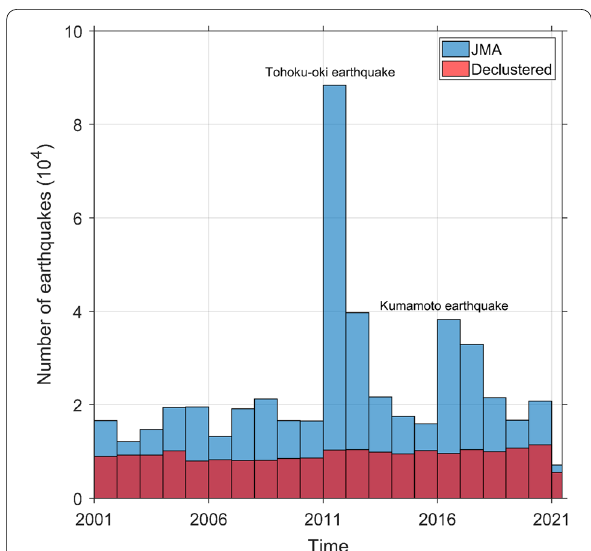
Fig. 2 The JMA earthquake catalogue (blue) and declustered earthquake catalogue (red). We use aftershock time–space identification windows from Gardner and Knopoff (1974). Earthquake swarms and possible triggered earthquakes following the 2011 Tohoku-oki earthquake are also removed. The declustered earthquake catalogue shows similar yearly earthquake occurrence level